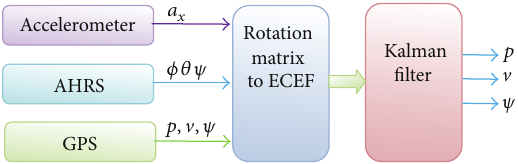
Figure 2: Block diagram of GPS/INS for position, velocity, and heading.